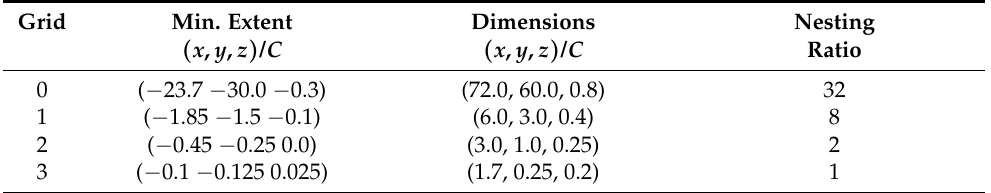
Table 1. Grid geometry and mesh size parameters of the nested grid set-up for LBM/pLBM-LES simulations of turbulent flows around a submerged foil of chord C , with a NACA-0012 profile in ( x , y ) streamwise direction, with its leading edge located at x = y = z = 0. LBM simulations are run in Grids 0-3, but pLBM simulations only use Grids 1–3. The foil span S extends to the cross-stream boundaries ( z -direction) of each grid, to the outermost lateral